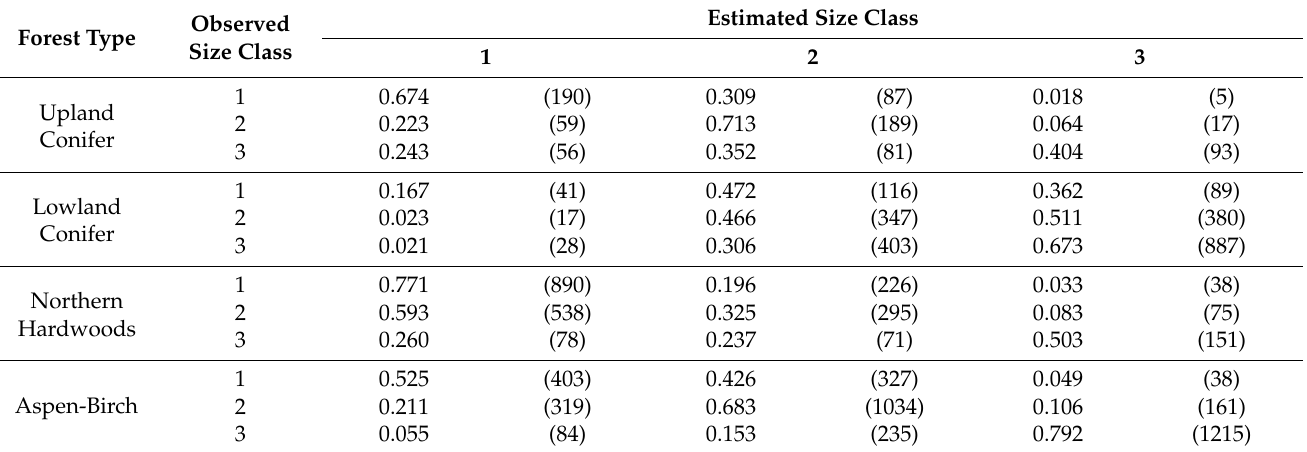
Table 3. Age class to size class crosswalk accuracy and error rates for each forest type/size class combi- nation, along with plot counts for each actual/estimated size class combination. Percentages reported as proportions of the observed total number of plots in a size class (i.e., conditional proportions based on rows). Size classes were coded as 1—sawtimber, 2—poletimber, and 3—seedling/sapling. Data came from FIA plot records spanning 1999–2013.